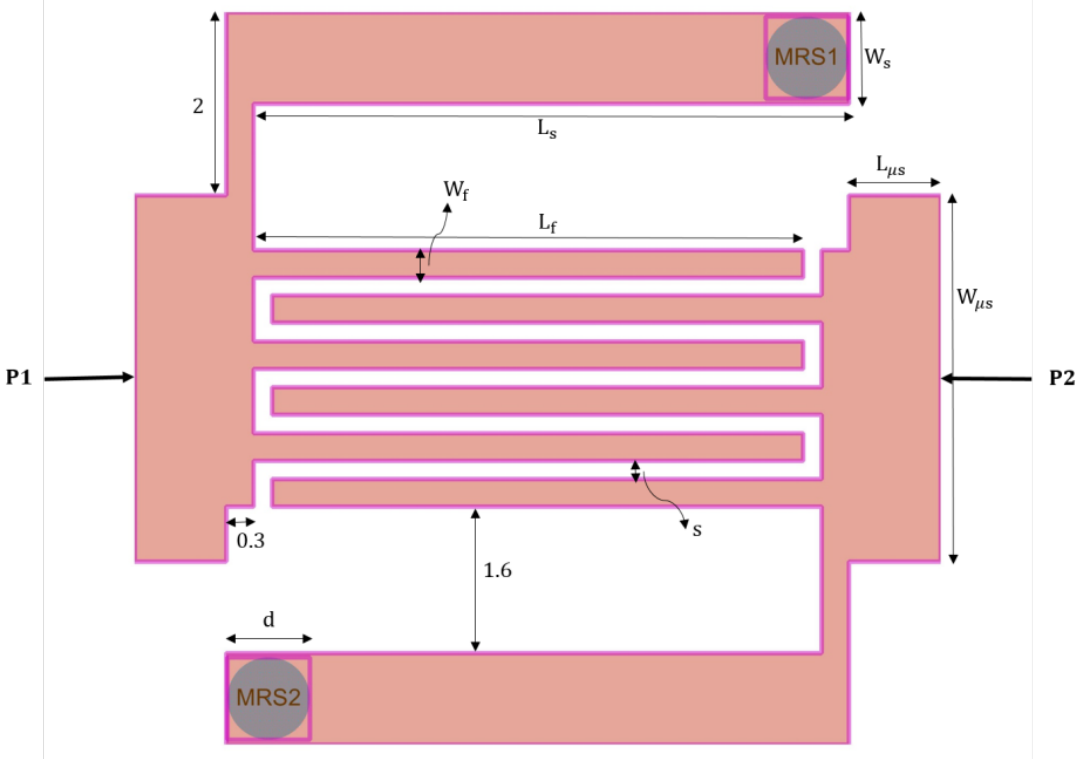
Figure 1. Proposed unit cell P-CRLH phase shifter with Magneto-static field Responsive Structures (MRSs). All dimensions are in mm ( L s = 6.8,W s = 1, L f = 6, W f = 0.3 L μs = 1,W μs = 4, s = 0.2, d = 0.9 ). The overall size is (0.24𝜆 𝑔 × 0.22𝜆 𝑔 ) ≌ 𝜆 𝑔 4 at the design frequency of 5.5 GHz.